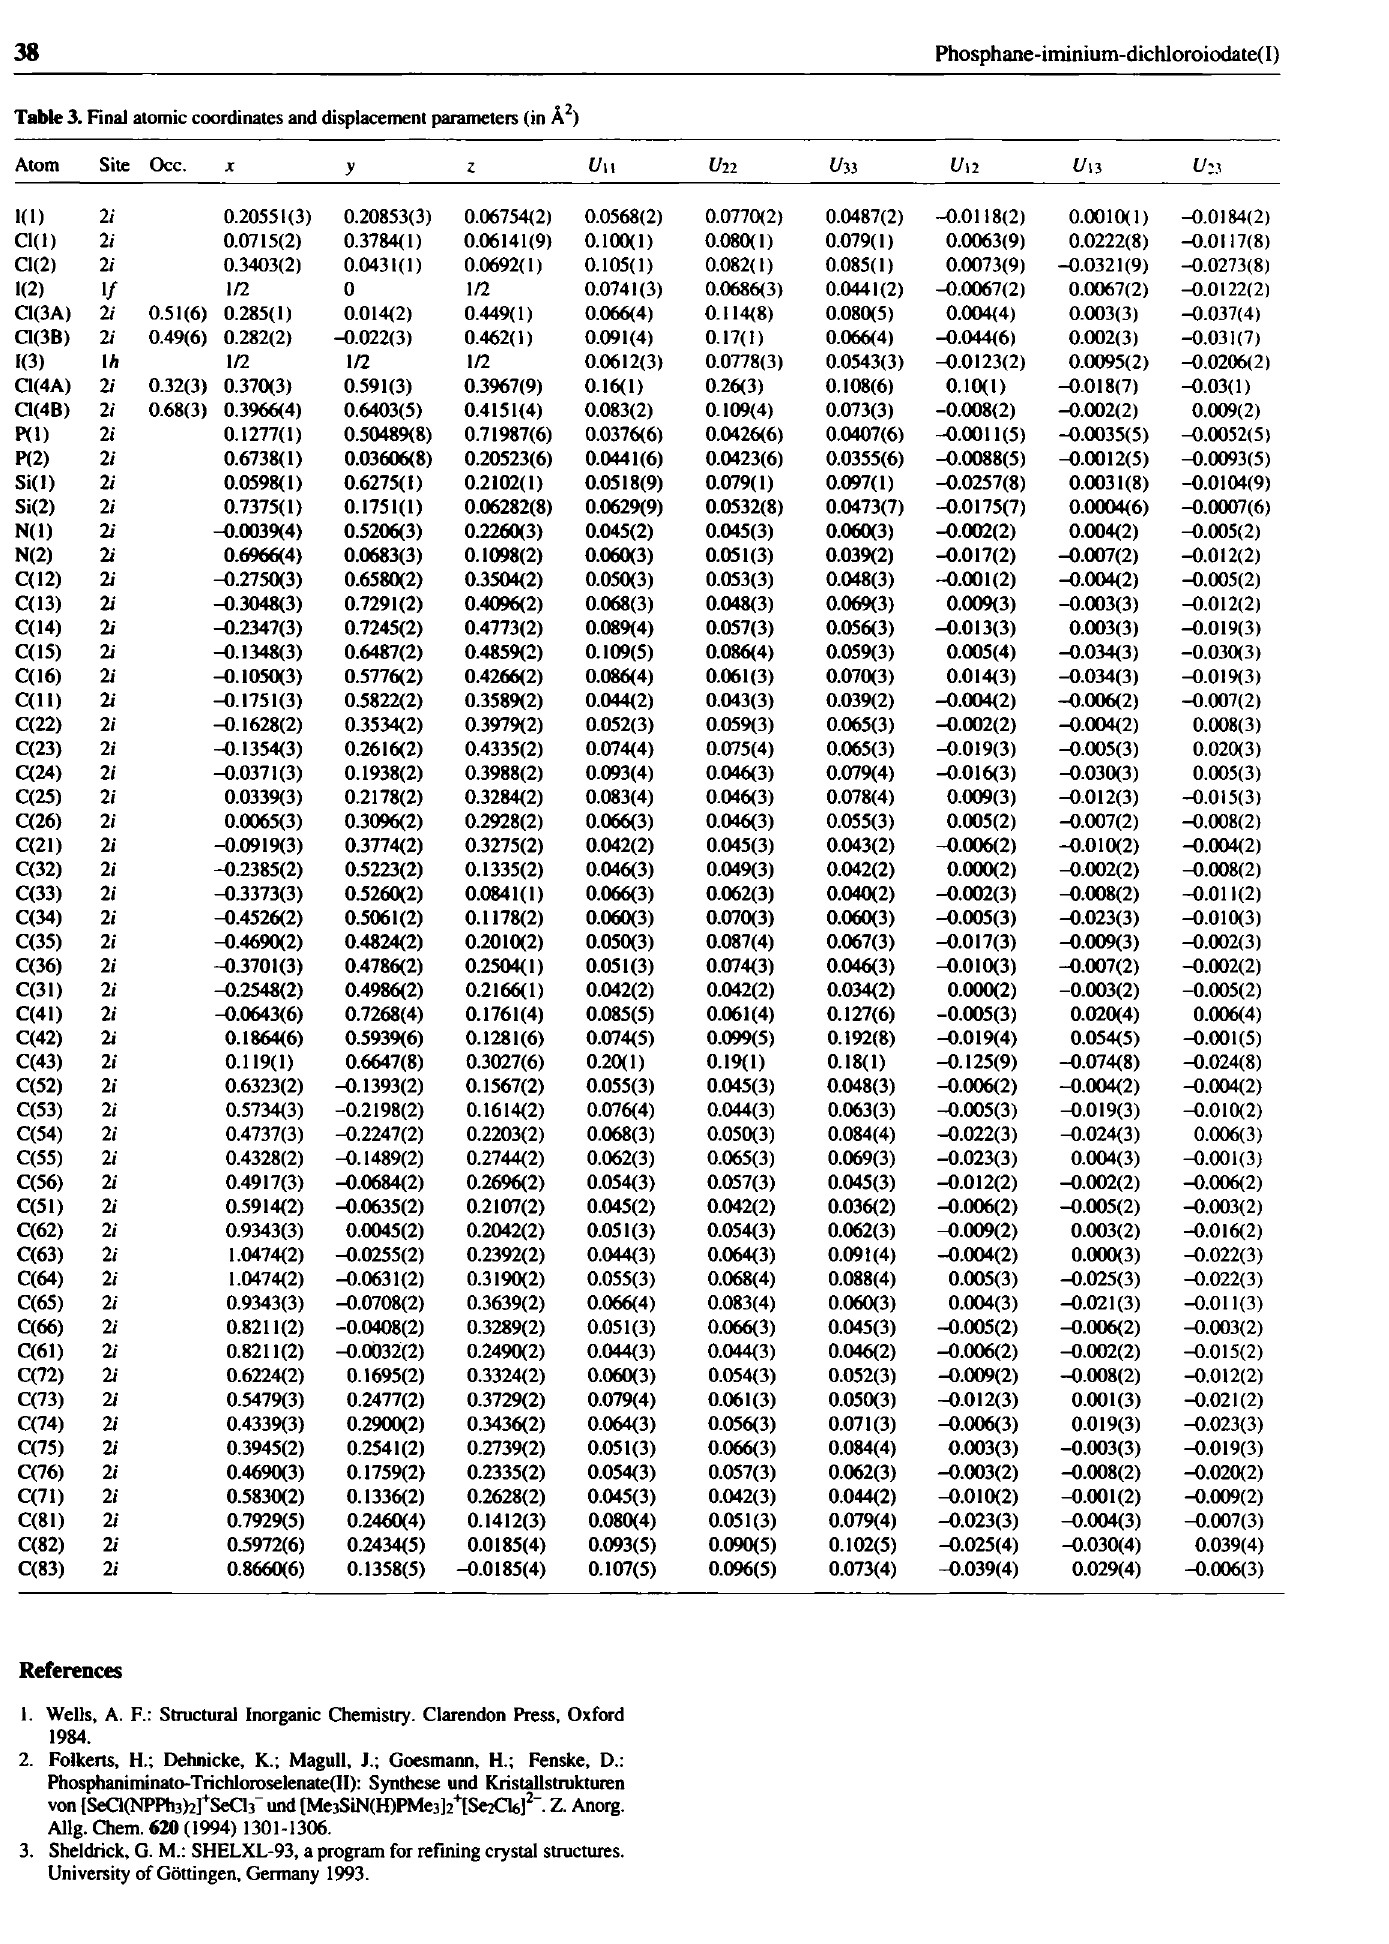
Table 3. Final atomic coordinates and displacement parameters (in À 2 ) Atom Site